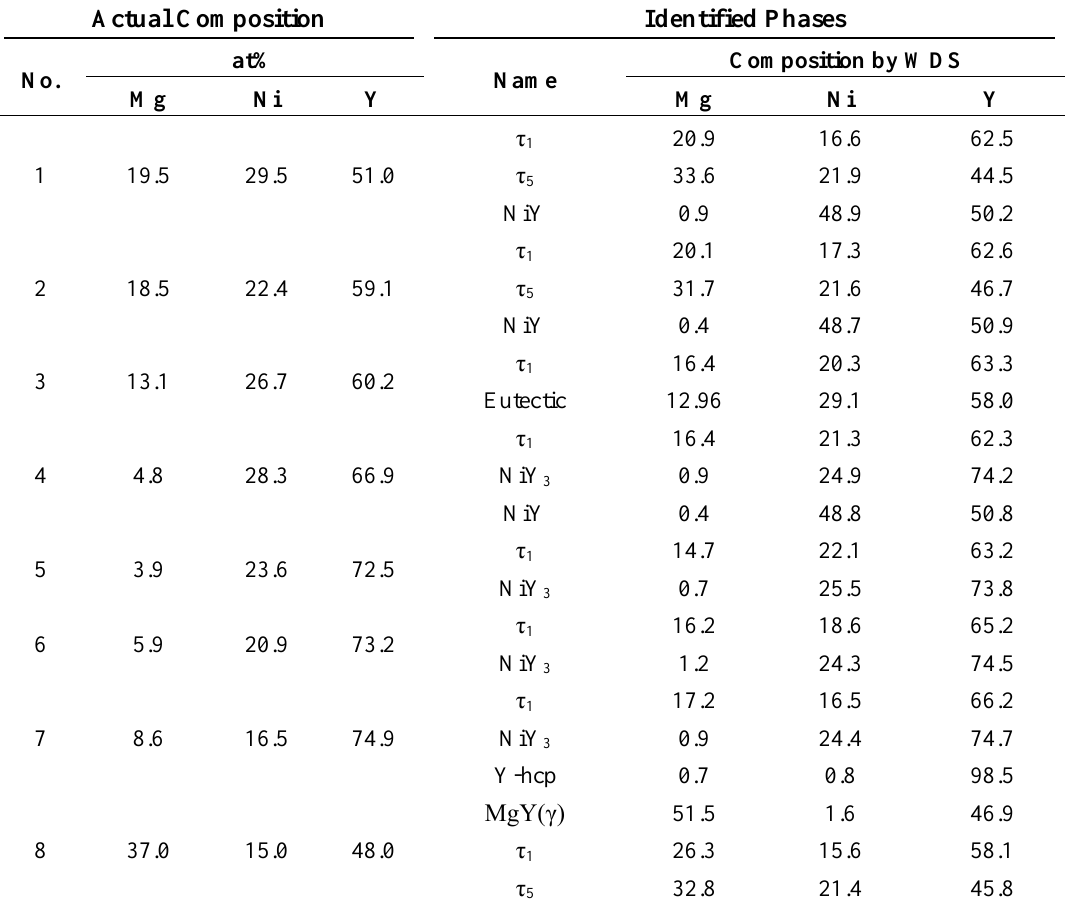
Table 2. Wave dispersive X-ray spectrometer (WDS) data of the samples 1–8 annealed at 673